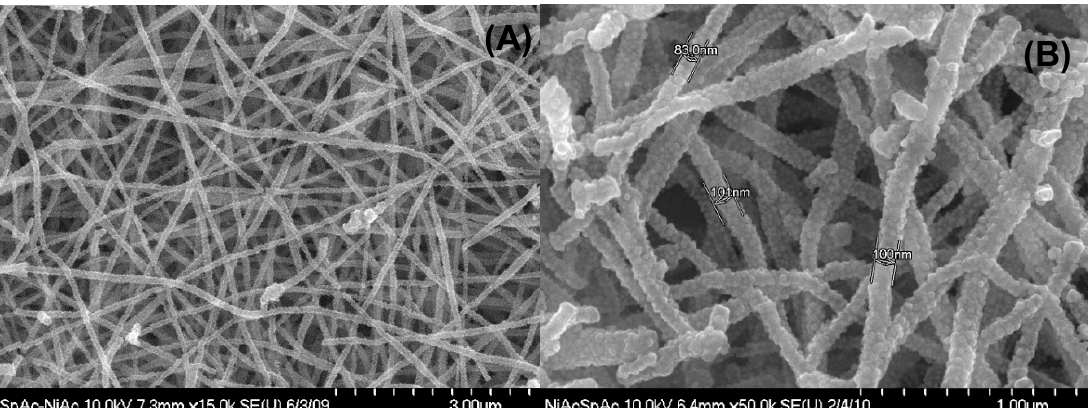
Figure 1. SEM; ( A ) and FE-SEM; ( B ) images for the prepared nanofibers containing 10 wt % Sn, and calcined at 850 °C.